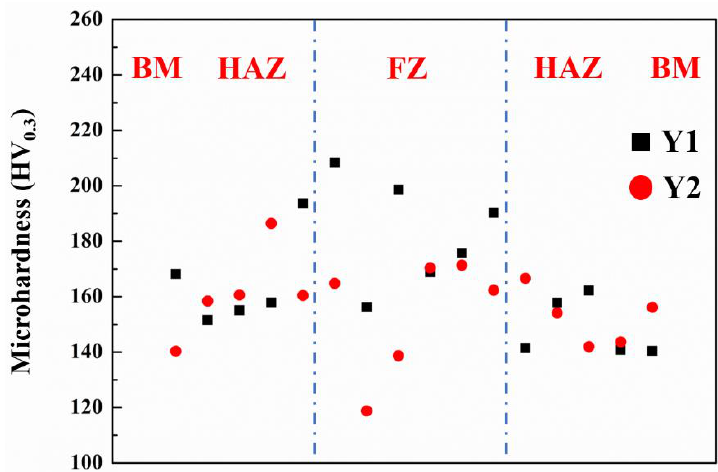
Figure 6. Microhardness curves of two samples.